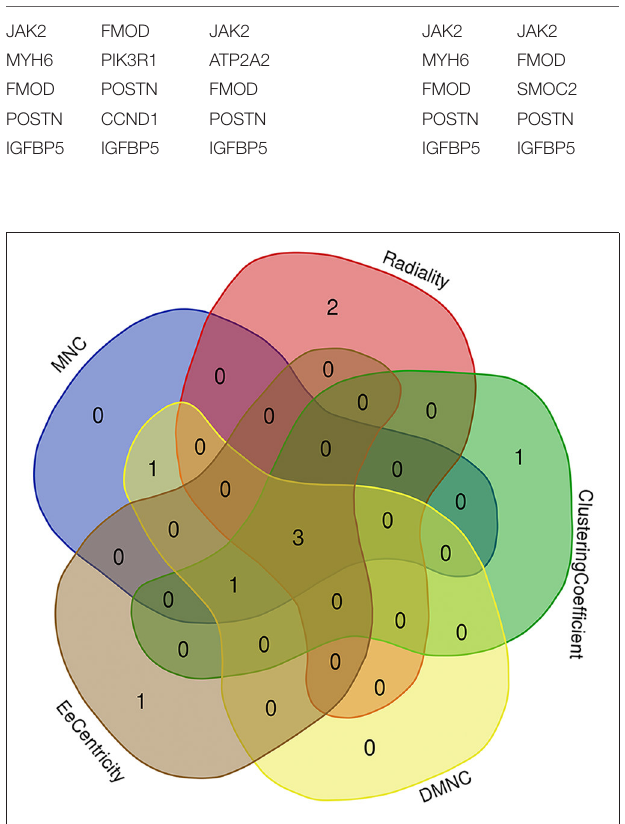
TABLE 2 | The top 5 hub genes as ranked in cytoHubba. MNC